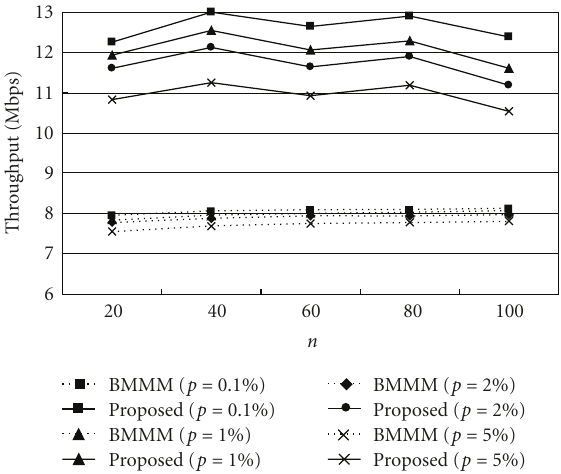
Figure 2: Throughput results with multicast and uplink user payloads of 1000